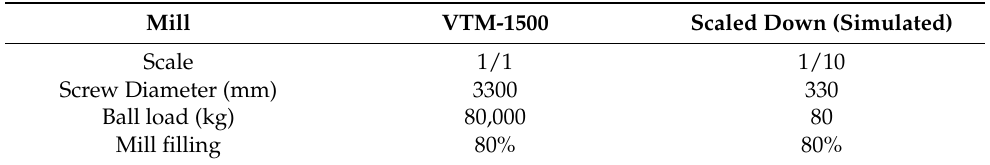
Table 1. Dimensions and operation parameters of VTM-1500 and its scaled-down version considered in the discrete element method (DEM)